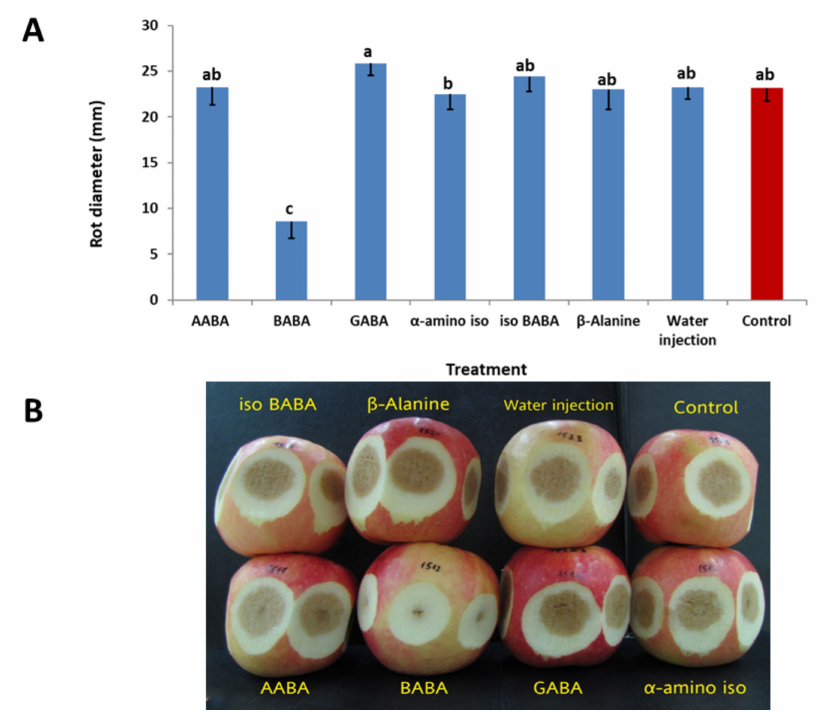
Figure 5. ( A ) Activity of various isomers of BABA on rot development in detached fruits. Bars represent the standard error of the mean. Different letters on columns indicate significant differences between treatments ( p < 0.05, Fisher’s LSD K-ratio t -test). ( B ) Photos of rot developed in mesoderm of fruits treated with various isomers of BABA (all at 1000 ppm). Control = untreated inoculated